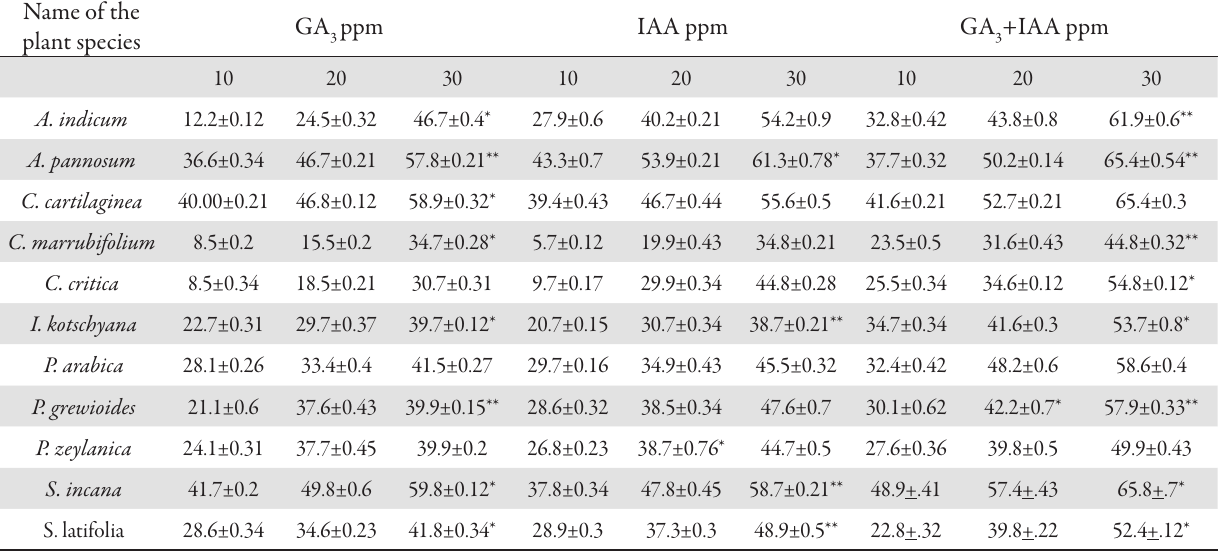
selected plant species of Kachchh